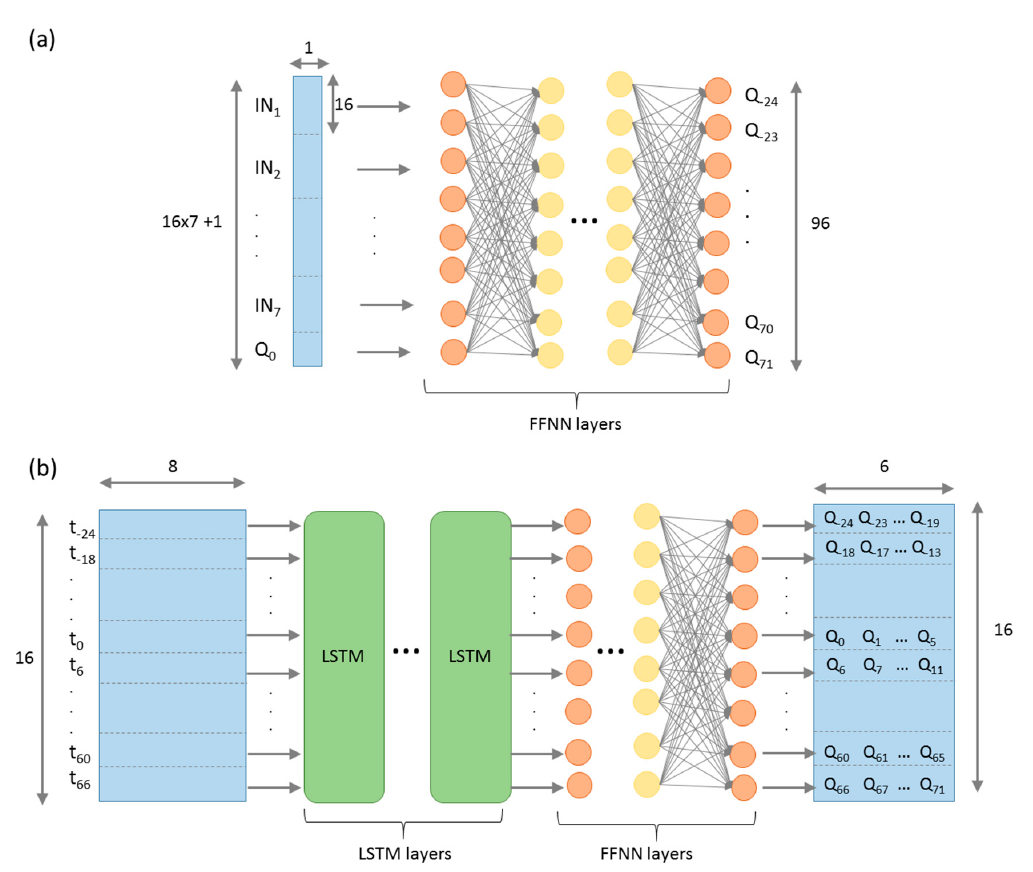
Figure 5. ( a ) Architecture for the Artificial Neural Networks (ANN) model, ( b ) architecture for the Deep Learning (DL) model.